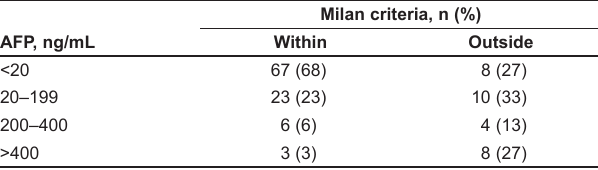
TABlE 6 Univariate analysis of potential determinants of success of hepatocellular cancer ultrasound surveillance in the detection of tumour in curable stages (Barcelona